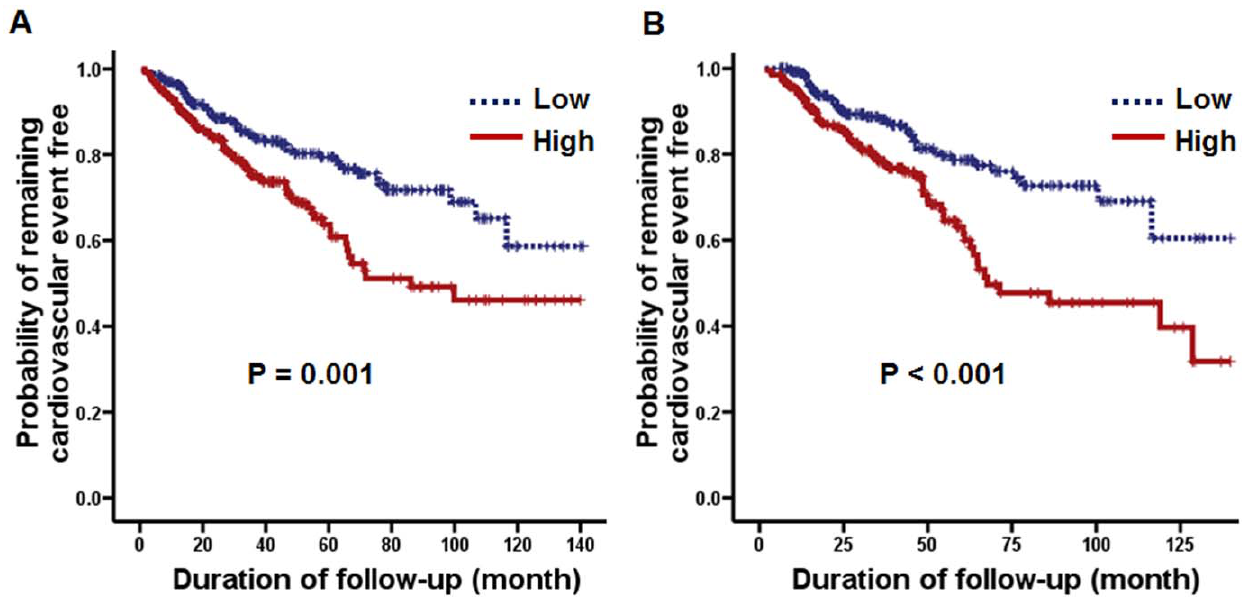
Figure 1. Kaplan-Meier plots of the probability of remaining cardiovascular event-free based on the median level (89.4 ml/day) of baseline peritoneal protein. (A) Intention-to-treat analysis. (B) As-treated analysis.